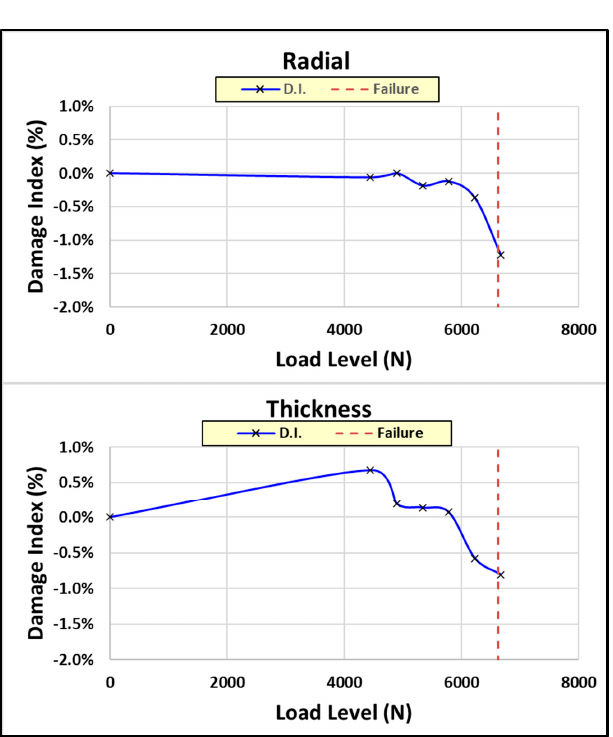
Figure 26. Sensor 11 damage index versus load level.